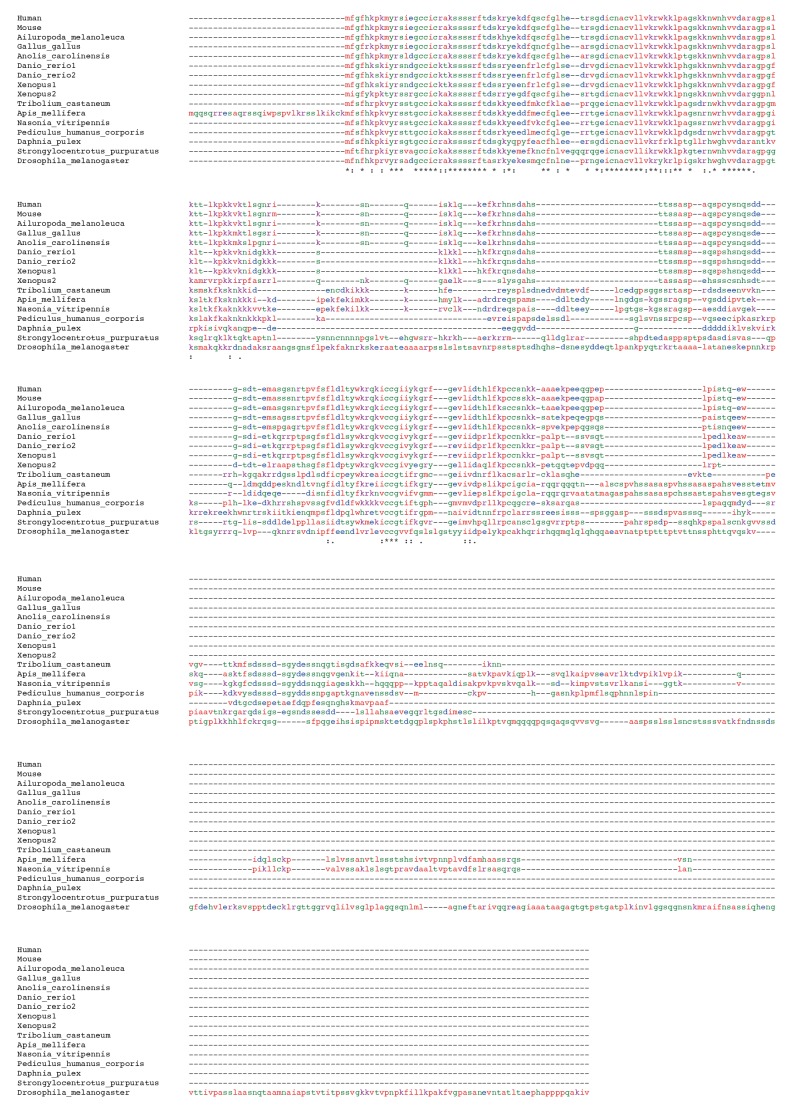
Alignment of the predicted amino acid sequences of Fam60a proteins by Clustal OMEGA.Asterisks, colons, and periods indicate positions with a fully conserved residue, conservation of highly similar properties, and conservation of weakly similar properties, respectively. Conserved hydrophobic residues (A, V, F, P, M, I, L, W) are shown in red, acidic residues (D, E) in blue, basic residues (R, K) in magenta, and hydroxyl-, sulfhydryl-, or amine-containing residues (S, T, Y, H, C, N, G, Q) in green.